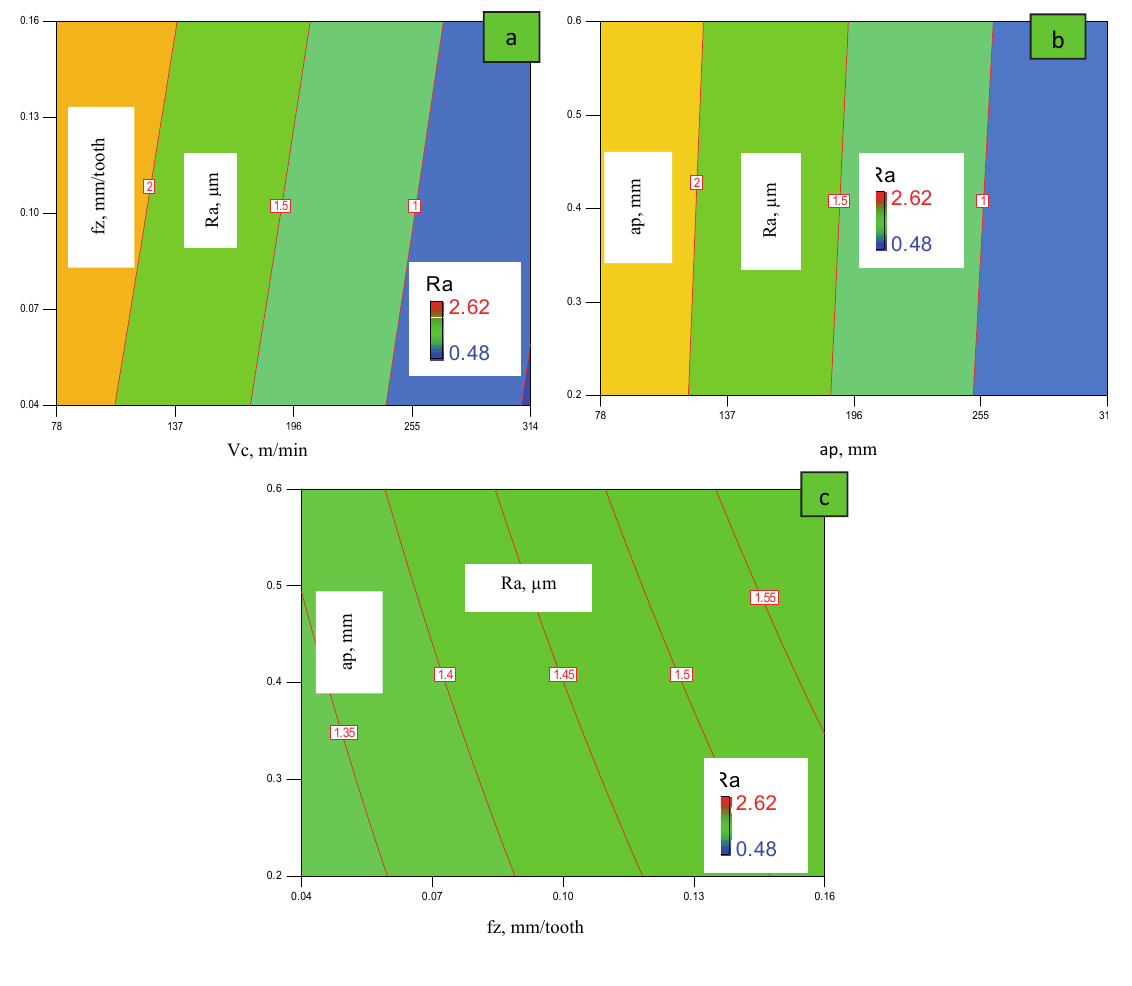
Fig. 7. Contour plot of R a = f (V c, fz, ap